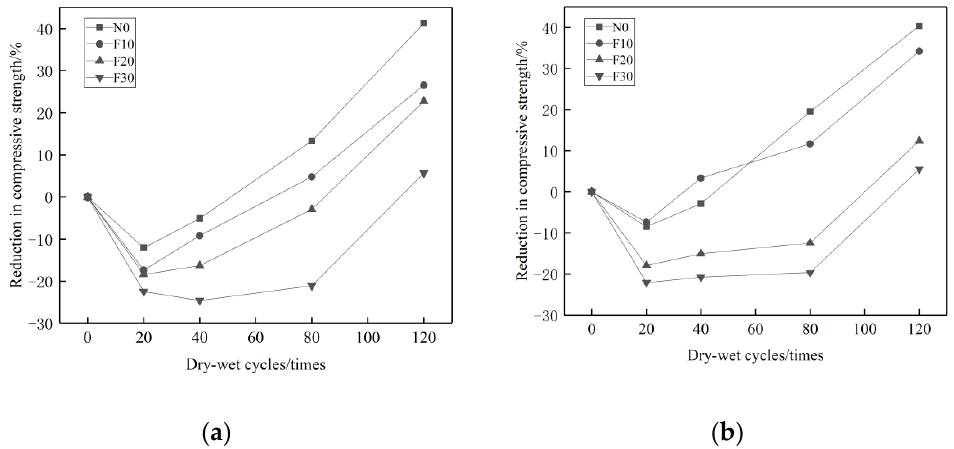
Figure 10. Loss rate of compressive strength of concrete with UFA dosage under different erosion conditions. ( a ) 10% Na 2 SO 4 , ( b ) 10% MgSO 4 .